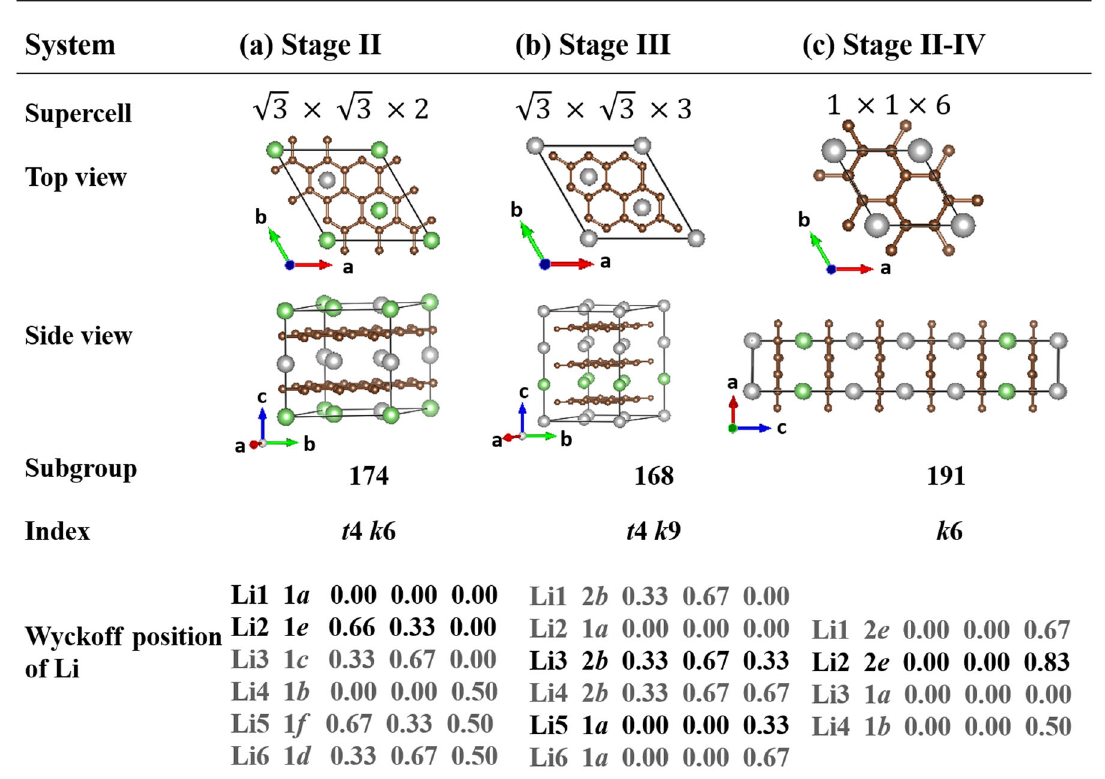
Fig. 6 Subgroup structures and Li/vacancy arrangements at Li 0.3333 C 6 . (a) stage II (b) stage III (c) stage II – IV. Subgroup structures and Li/ vacancy arrangements of stage II, stage III, and stage II − IV at Li 0.3333 C 6